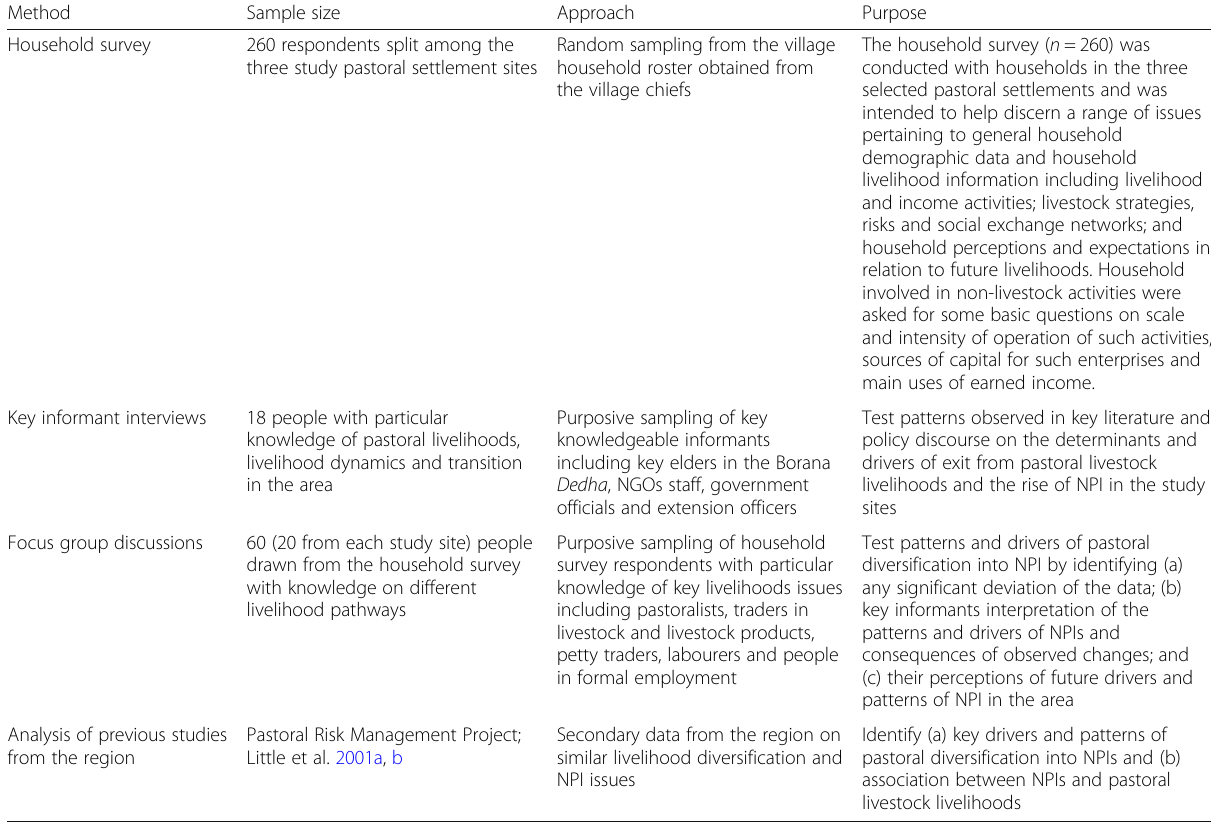
Table 1 Summary of research